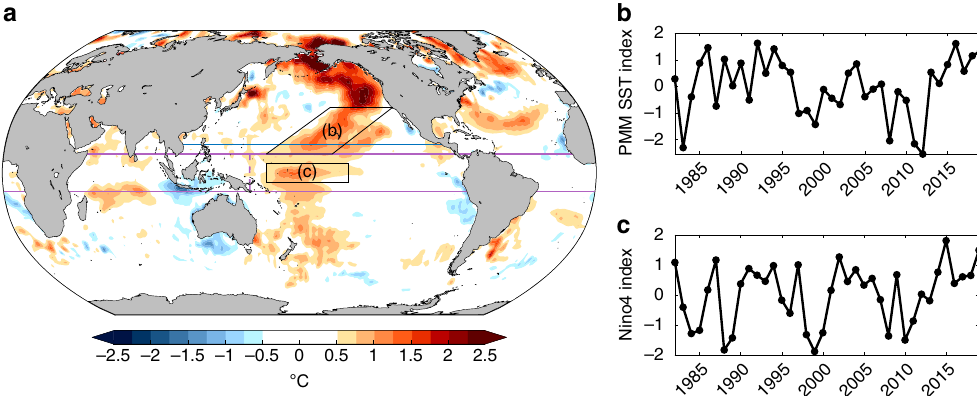
Fig. 4 Summer 2019 surface temperature anomalies and model domains. a Global observed sea surface temperature anomalies (SSTAs; °C; shading) used to force our atmospheric model experiments. Domain for tropical SST-forced experiment is 10 °S – 10 °N at all longitudes (i.e., equatorward of solid purple lines). Domain for North Paci fi c SST-forced experiment is poleward of 15 °N to the coastlines (i.e., poleward of solid blue line). Vertical dashed purple line represents separation point for tropical Indian and tropical Paci fi c Ocean experiments (Supplementary Fig. 4). Black boxes represent areas of interest in ( b ) and ( c ). b Normalized June – August (JJA)-averaged Paci fi c Meridional Mode SST index (see “ Methods ” ). c Normalized JJA-averaged SSTA area-weighted averaged in the Nino4 region. Each time series is shown for the period 1980 –